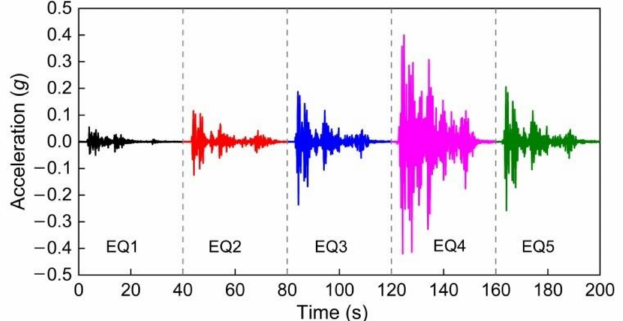
Figure 2. Time histories of input motions forinstrument